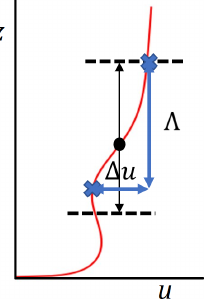
Figure 1. Calculation of the vertical component of eddy viscosity by finding the points of minimum and maximum velocity within a given height